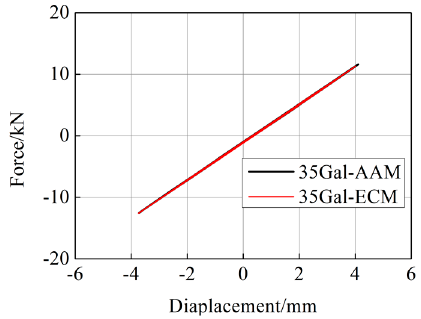
Figure 9. Hysteretic loops of numerical column (35 Gal).